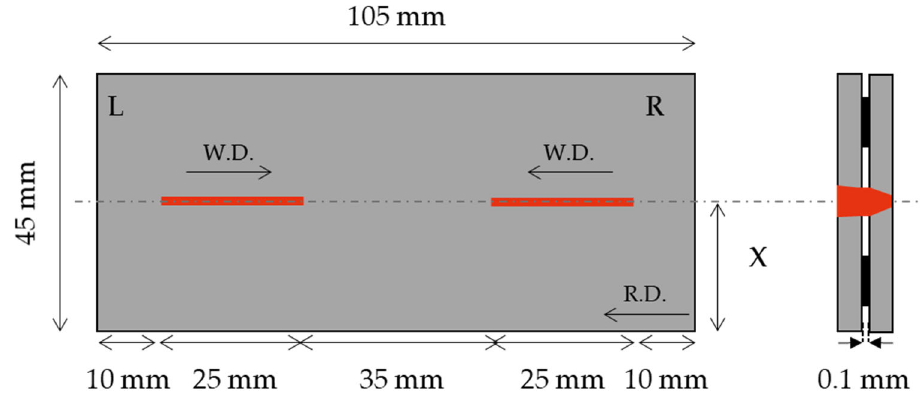
Figure 2. Fully overlapping sample geometry (W.D. for welding direction and R.D. for rolling direction).